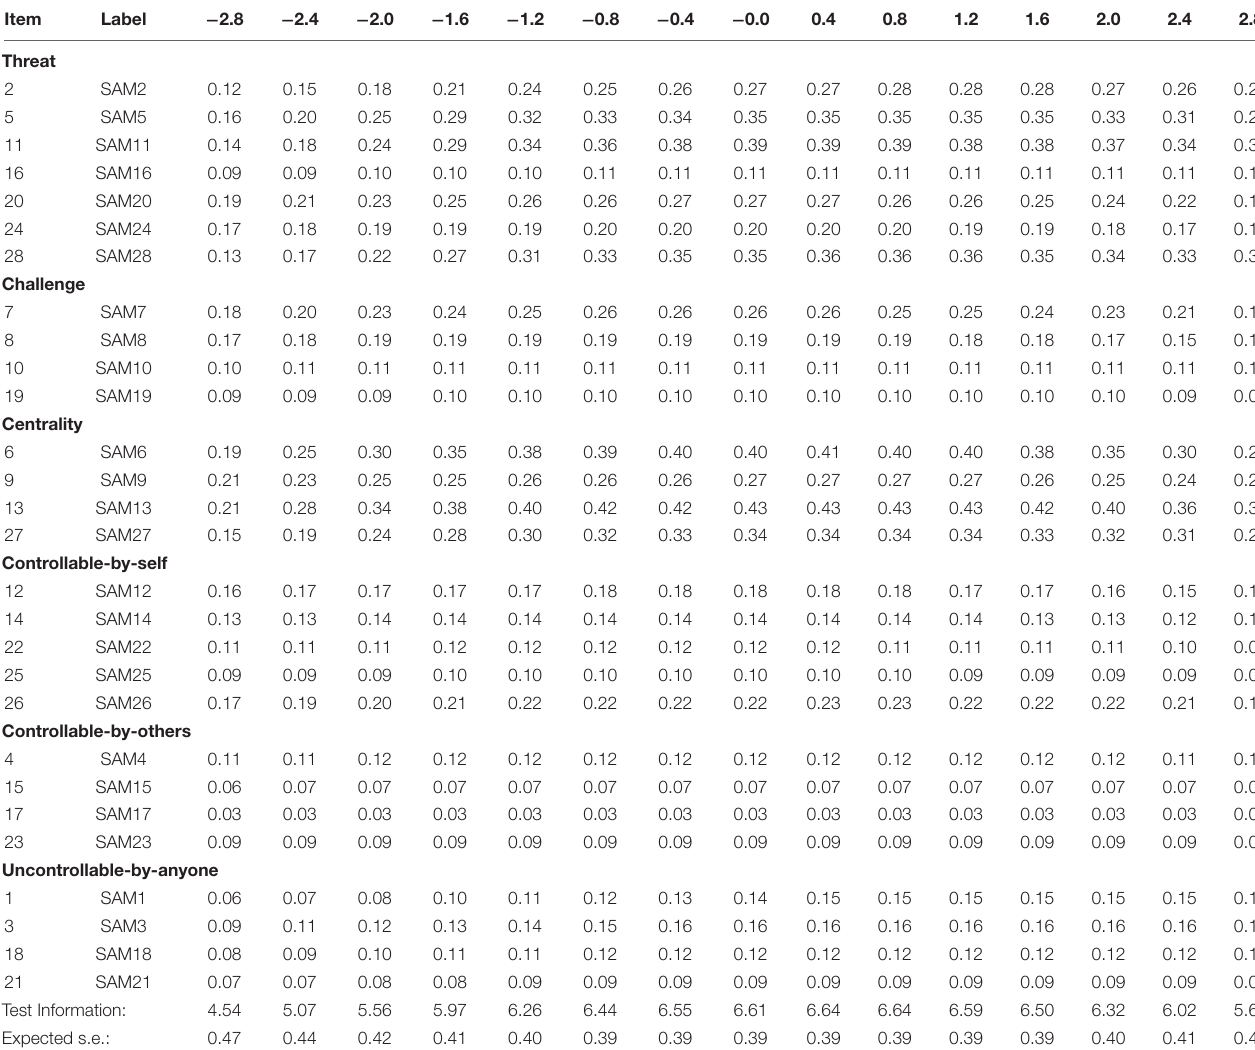
TABLE 4 | Item information function values at 15 values of θ from − 2.8 to